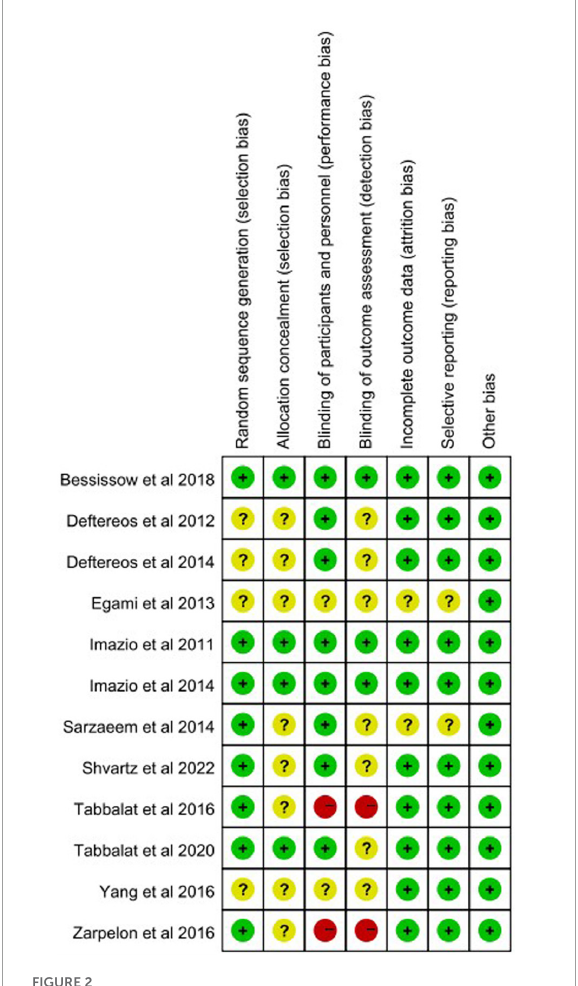
FIGURE2 Quality assessments for included studies. Green/plus indicates low risk of bias, yellow/question mark suggests the uncertain risk of bias, and red/minus shows potential high risk of